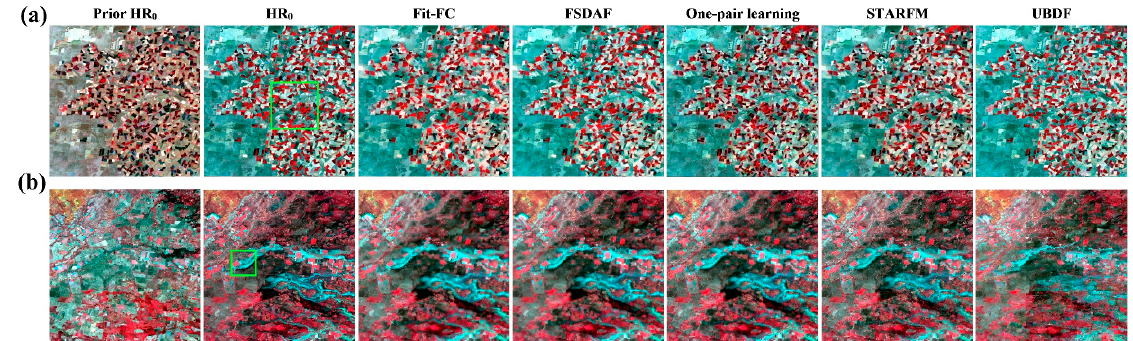
Figure 4. Landsat images observed on prior date (Prior HR 0 ) and prediction date (HR 0 ), and the predicted Landsat-like images at ( a ) the Coleambally site and ( b ) the Gwydir site. Prior HR 0 in Coleambally site was acquired on 4 December 2001, and HR 0 was acquired on 5 January 2002; prior HR0 Gwydir site was acquired on 26 November 2004, and HR 0 was acquired on 12 December 2004.